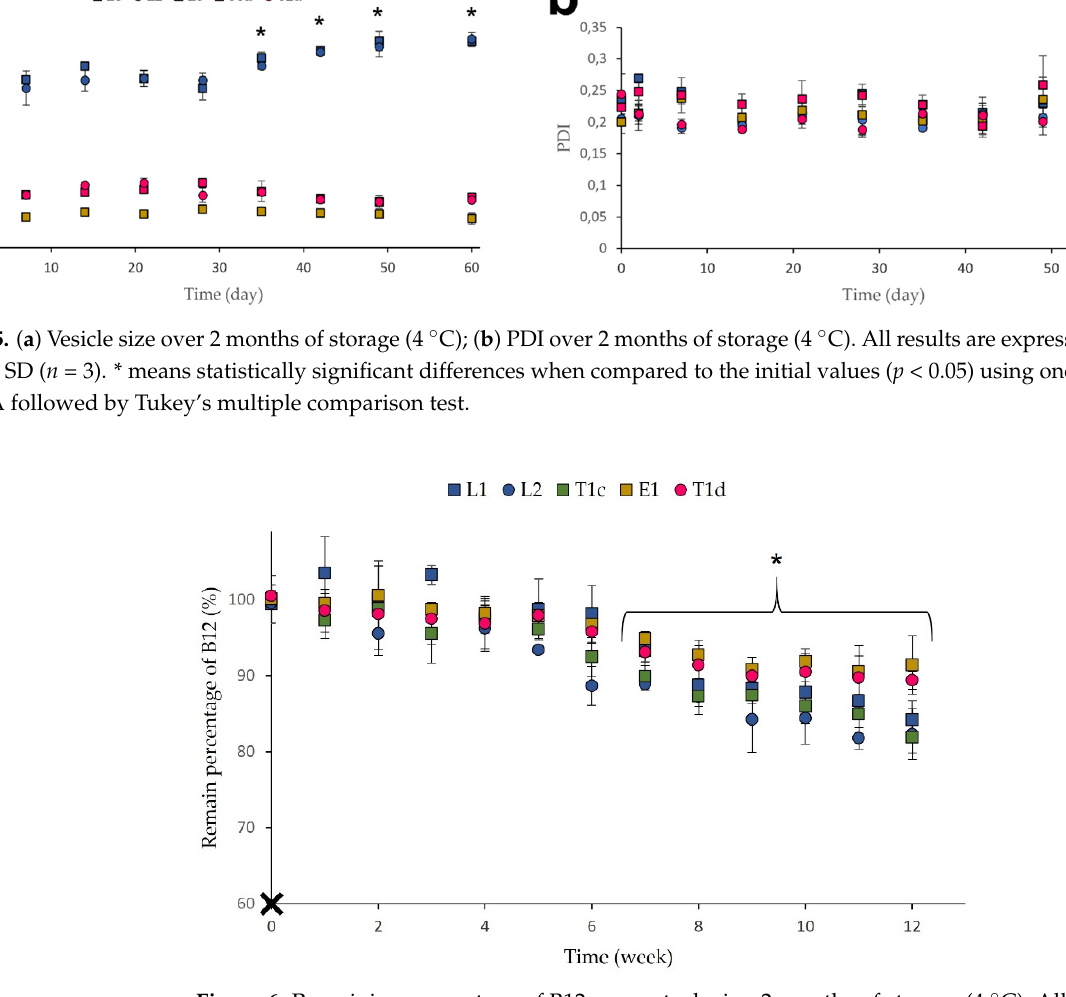
Figure 6. Remaining percentage of B12 amounts during 2 months of storage (4 °C). All results are expressed as mean ± SD ( n = 3). * means statistically significant differences when compared to initial values ( p < 0.05) using one-way ANOVA followed by Tukey’s multiple comparison test.